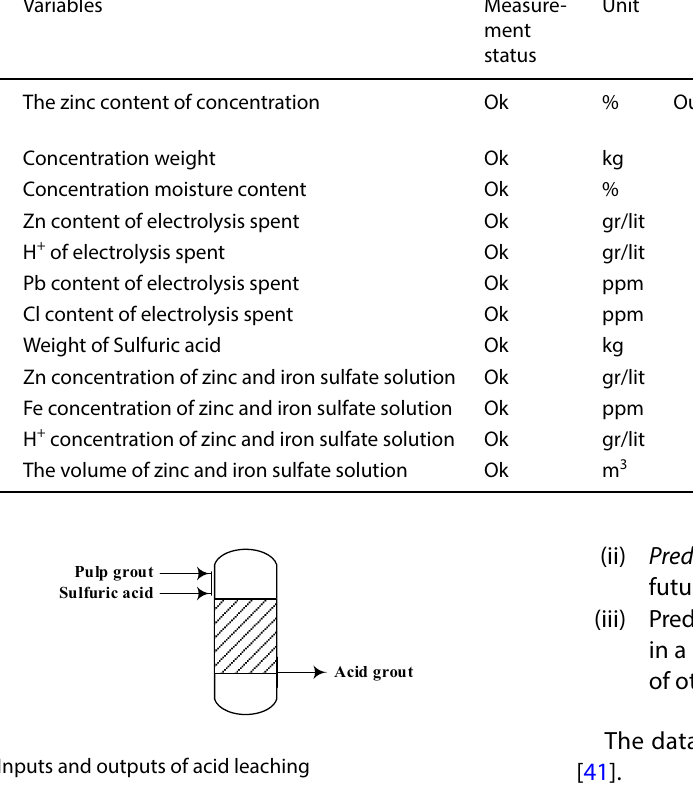
Table 3 The input and output variables of pulp making and their measurement status Variables